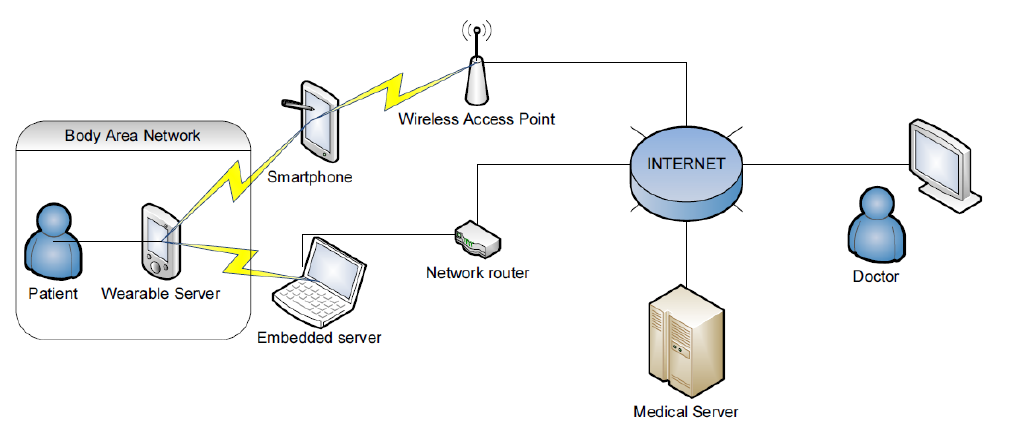
Figure 2. Human behavior tracing–network